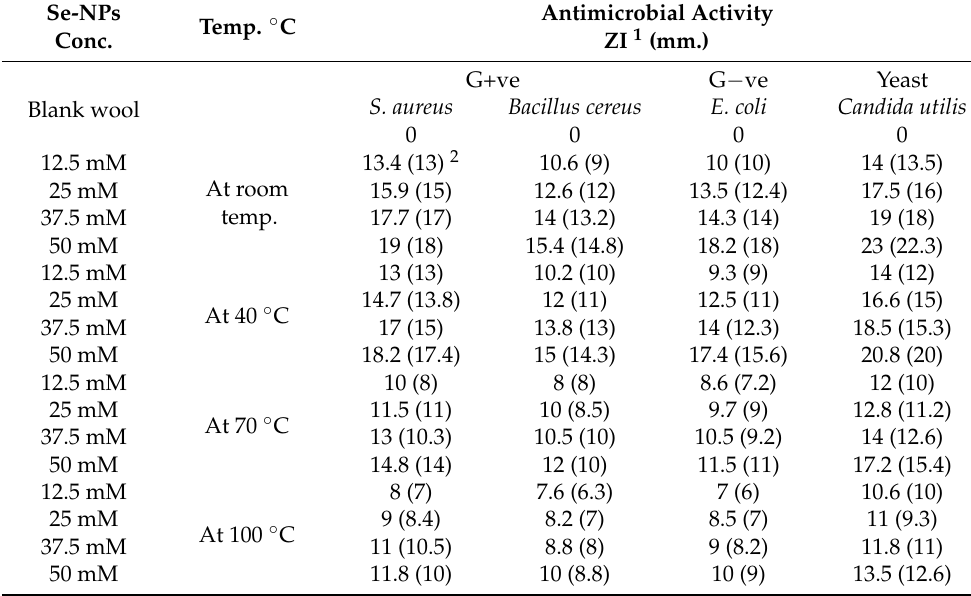
Table 1. Antimicrobial activity of the Se ‐ dyed wool fabrics at different temperatures. Se ‐ NPs conc. Temp. °C